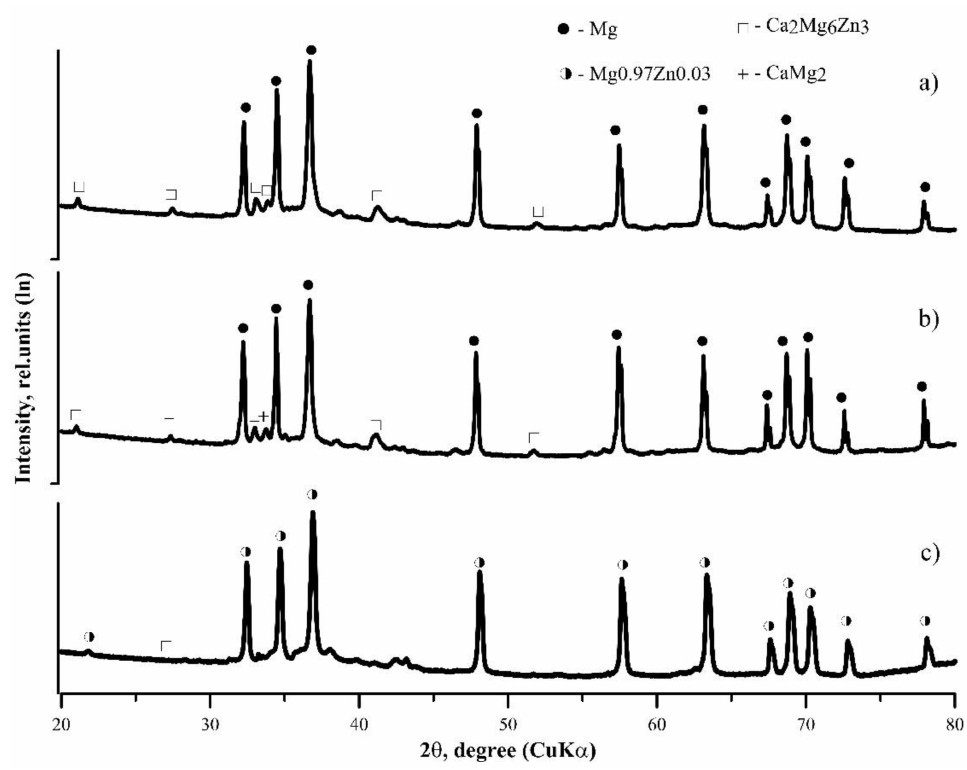
Figure 5. XRD patterns of magnesium alloys Mg–Ca–Zn reference ( a ), Mg–Ca–Zn–ND ( b ) and Mg–Ca–Zn US ( c ).